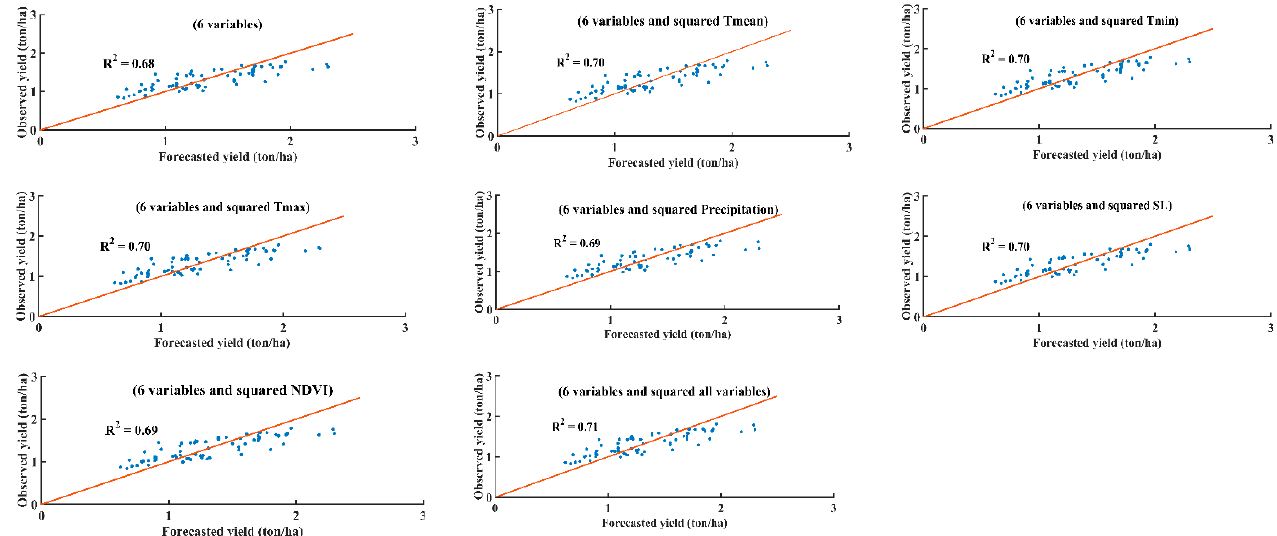
Figure 8. Predict yield of tea by RF model with 6 variable input or 6 variable input and squared one of the variable in order to: Tmean, Tmin, Tmax, Precipitation, Solar radiation, NDVI and all variables.